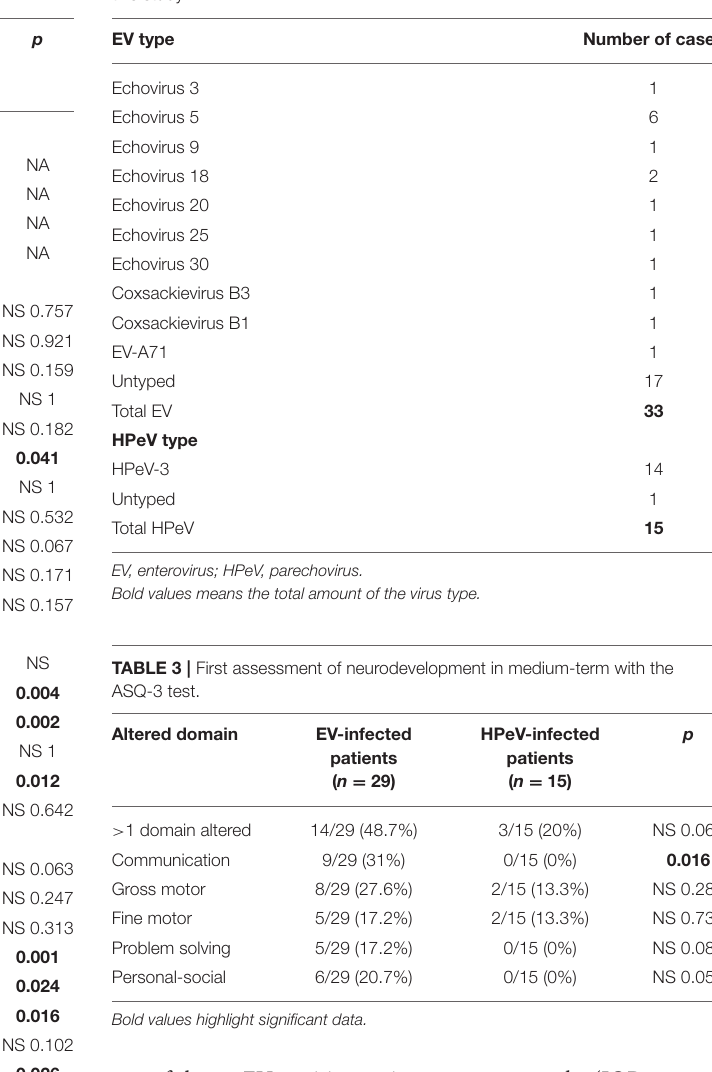
TABLE 2 | EV and HPeV types identified in the samples from patients included in this study.